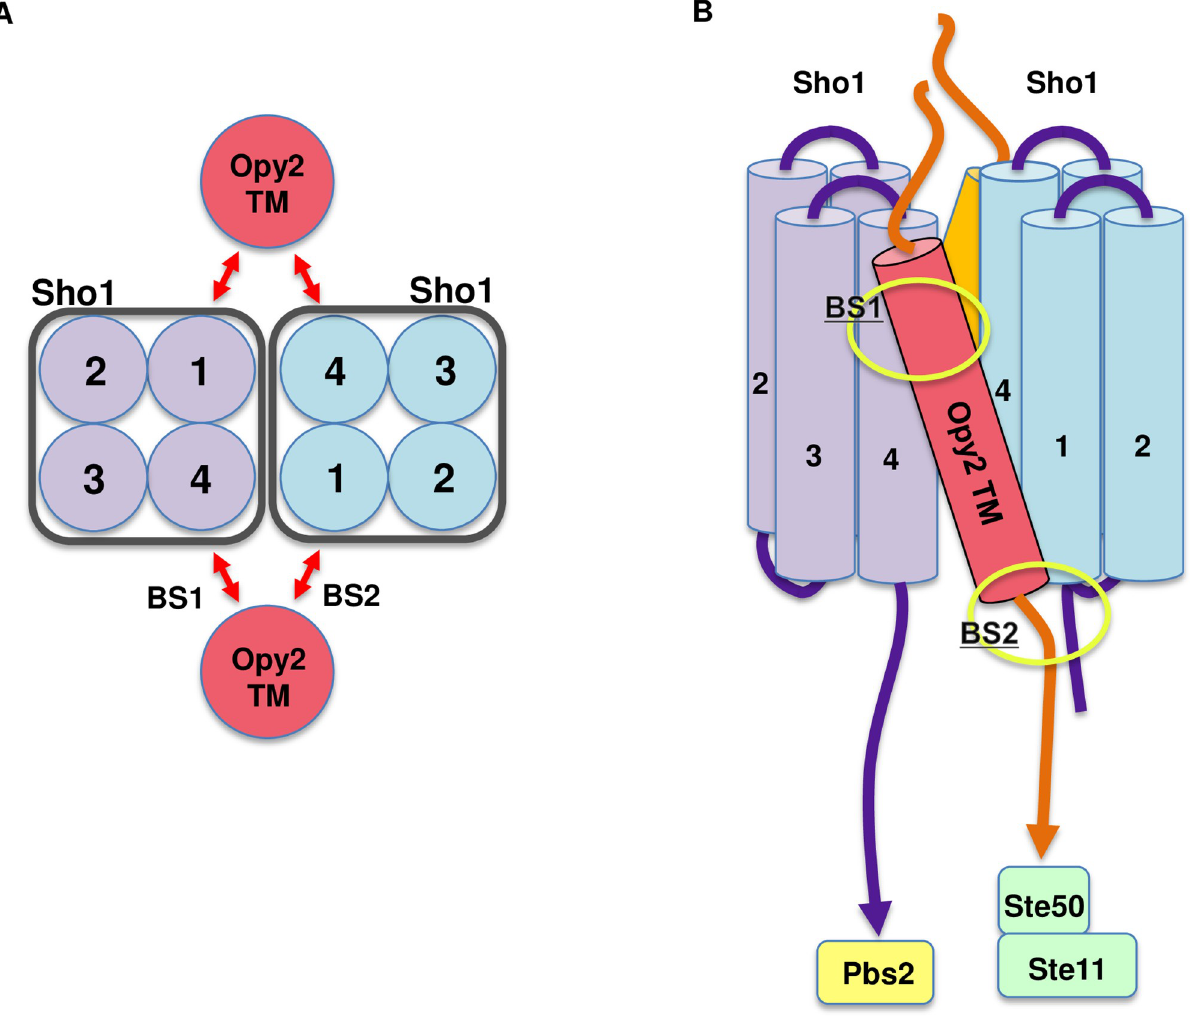
Fig 7. Schematic model of the transmembrane interactions between Sho1 and Opy2. (A) A top view of the interaction between an Sho1 dimer and two Opy2 monomers. Light purple/blue circles with numbers represent the four TM domains of Sho1. Red circles represent the TM domain of Opy2. Red arrows indicate the TM-TM interactions between Sho1 and Opy2 at the binding sites 1 and 2 (BS1 and BS2). (B) A side view of the interactions among an Sho1 dimer and two Opy2 monomers. Transmembrane (TM) domains of Sho1 and Opy2 are indicated as light purple/blue and red cylinders, respectively. Extracellular and cytoplasmic regions that are connected with TM domains are partly shown as a line. BS1 and BS2 are indicated by yellow ovals.